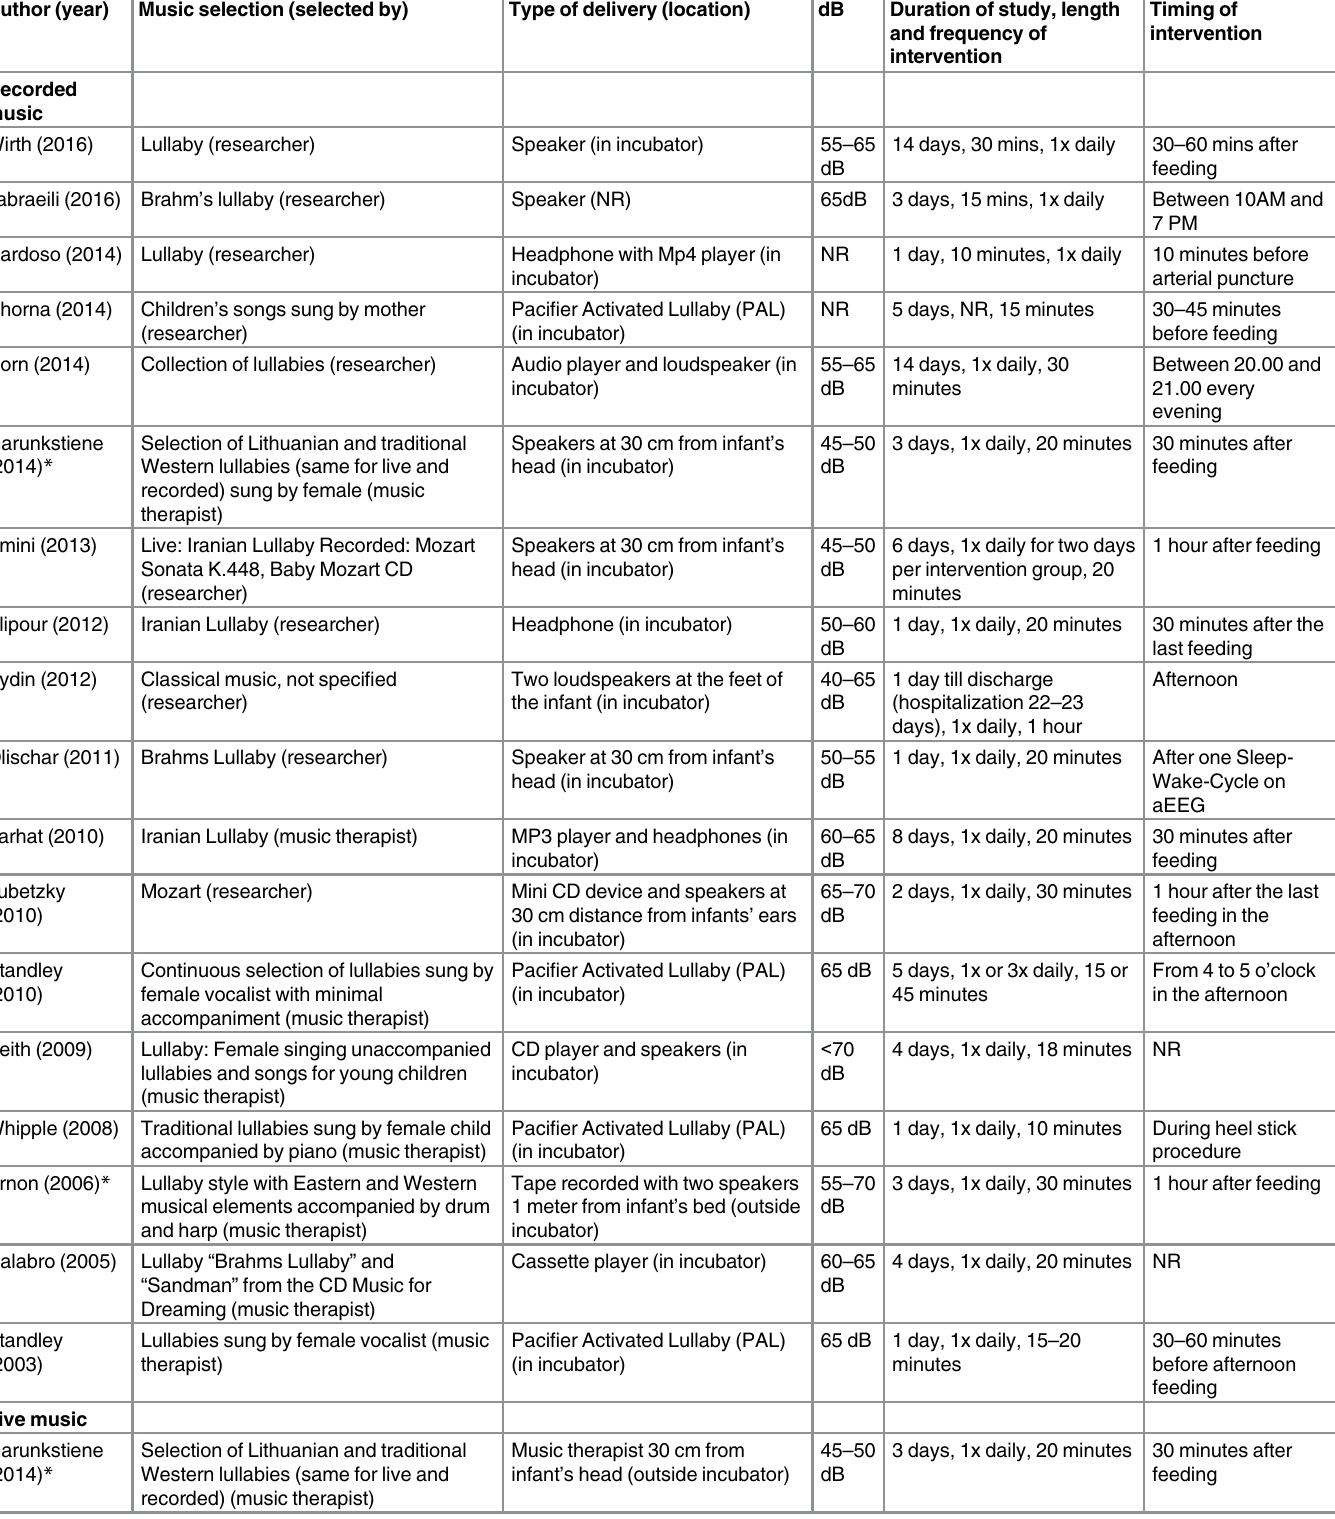
Table 2. Characteristics of music interventions per study. Characteristics of music interventions per